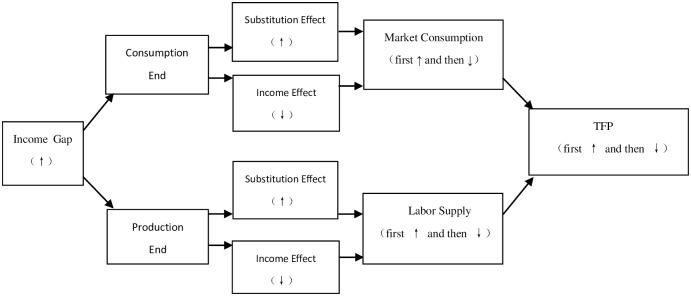
Technical roadmap.